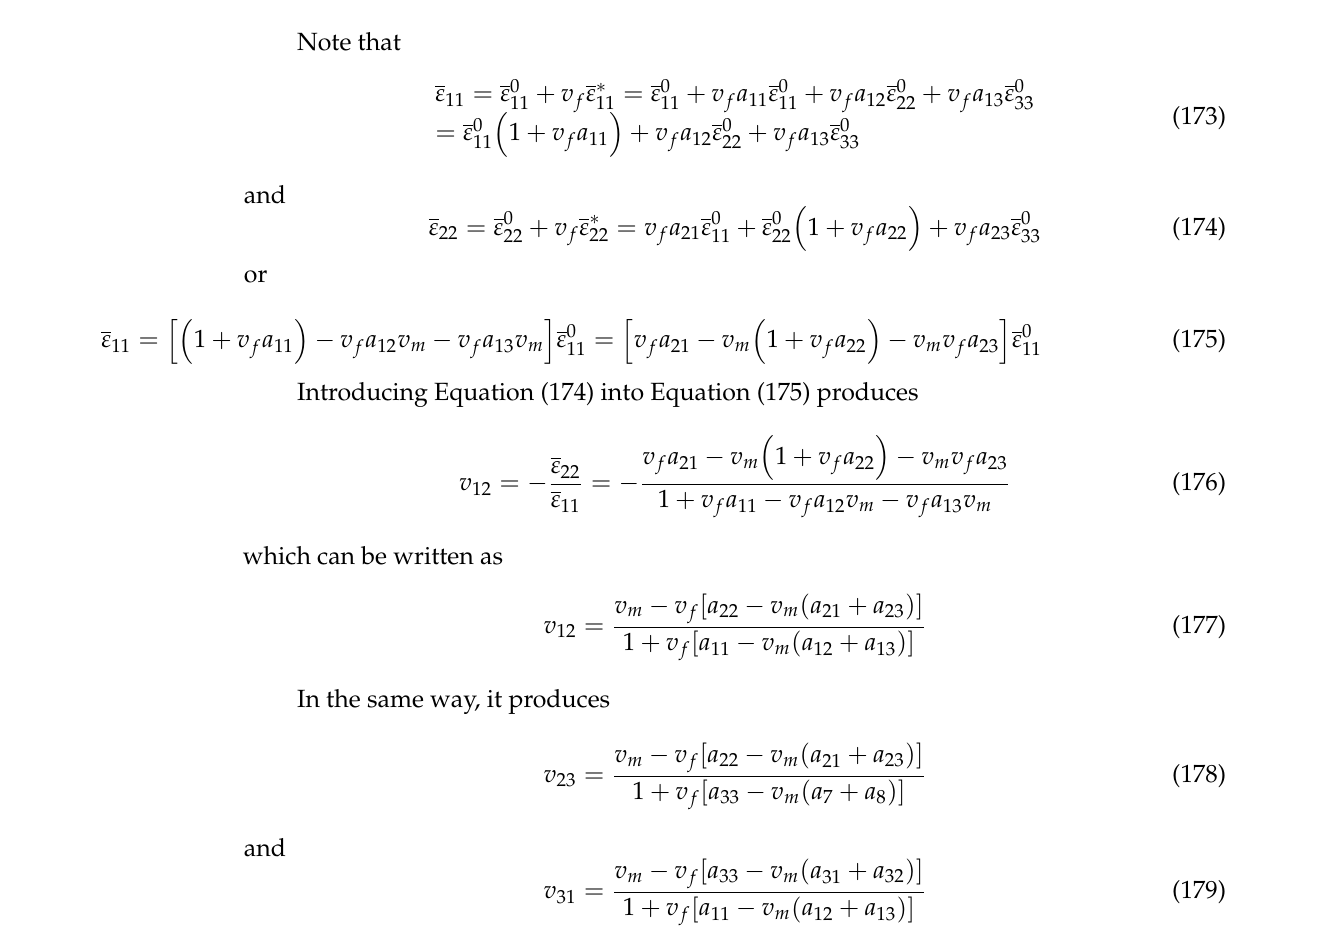
Figure 7. Finite element model 2 for a RUC. The mechanical constants used in the application are E m = 4.14 GPa ; v m = 0.22; E f = 86.90 GPa ; v f = 0.34